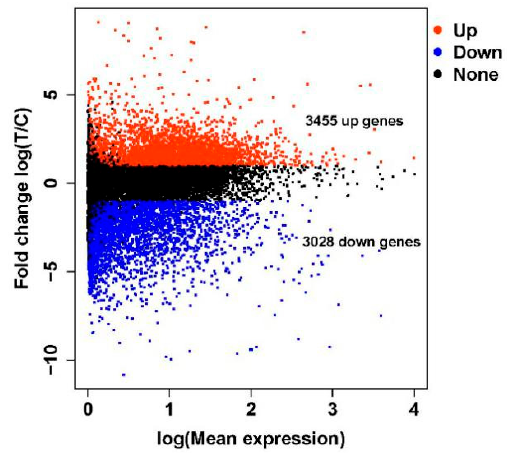
Figure 1. A volcano plot of the differentially expressed genes between ‘lactating’ and non-‘lactating’ crops.